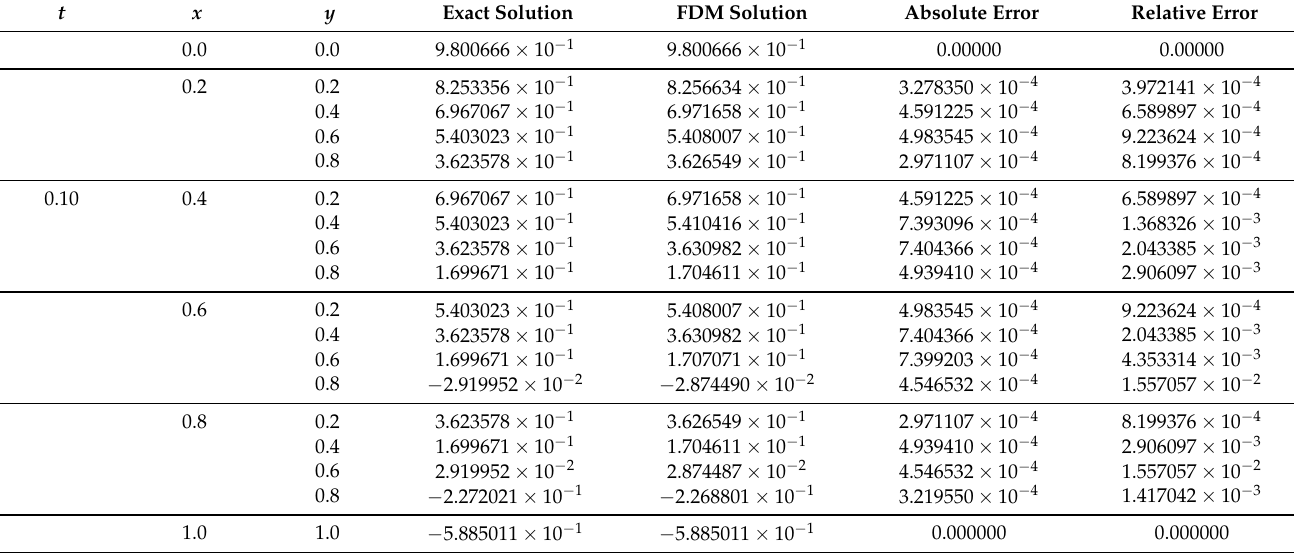
Table 3. A comparison between the exact solution and FDM solution at some values of x and y three different time